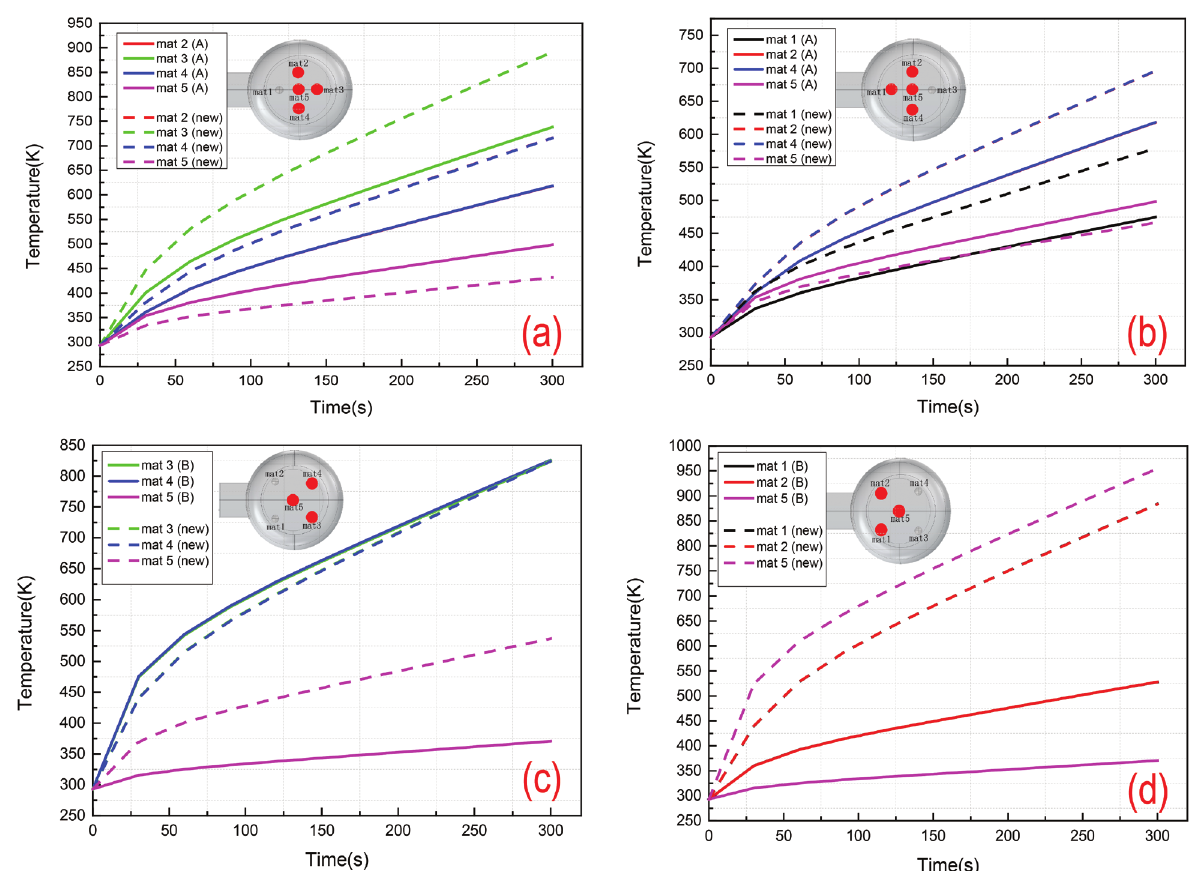
Figure 8: The heating curve for missing array of Y-TZP, at h = 340 mm.